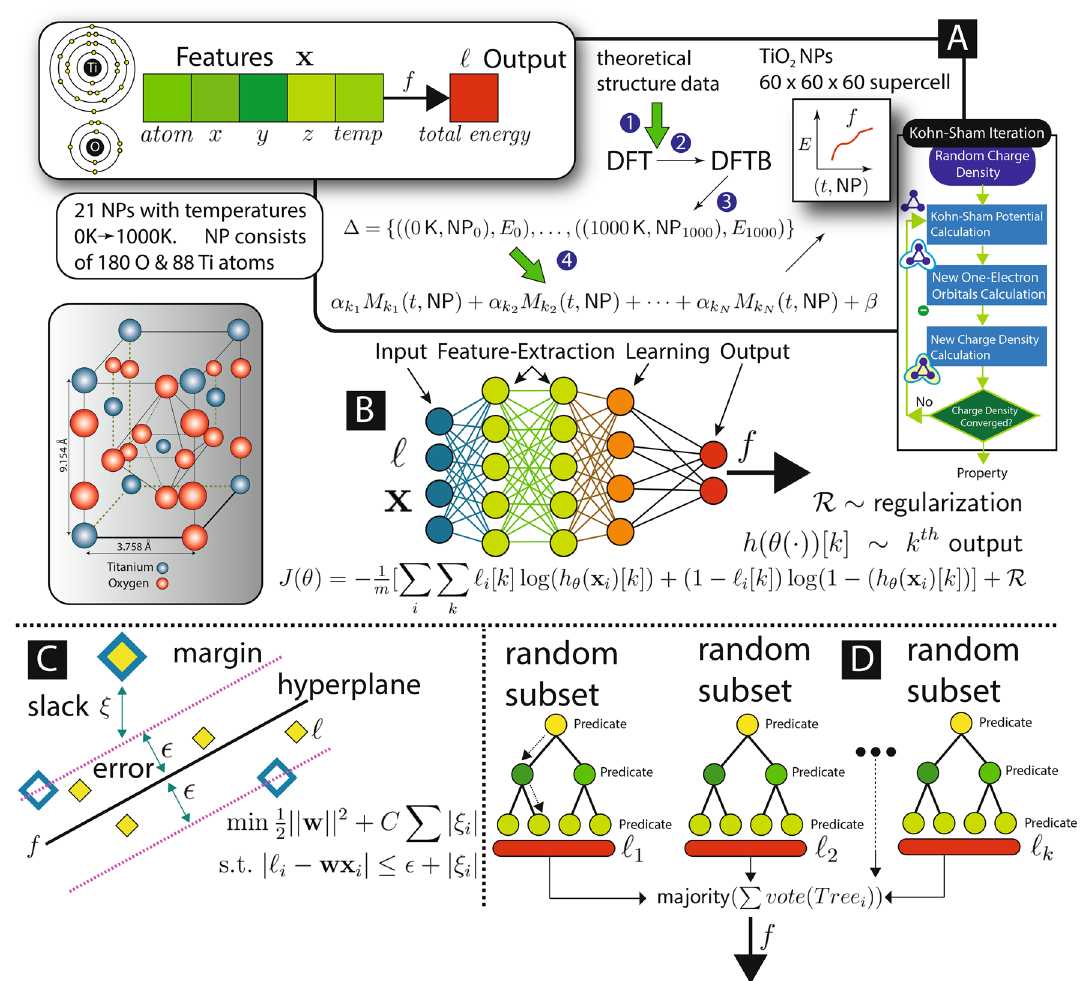
Figure 3. (Inset right) Flowchart of the algorithm used in the self-consistent solution of the Kohn–Sham equations. Cooperative model framework (co-model) that leverages an ensemble of models driven by data. (Top left) are the features and label. We show a sample of the diversity of models: neural nets, support vector machines, random forests. (Top middle) the steps 1–5 using co-modelling for TiO 2 NPs. Use DFT/DFTB (1–3) to generate minimal viable data (21 data points), select, train, co-model